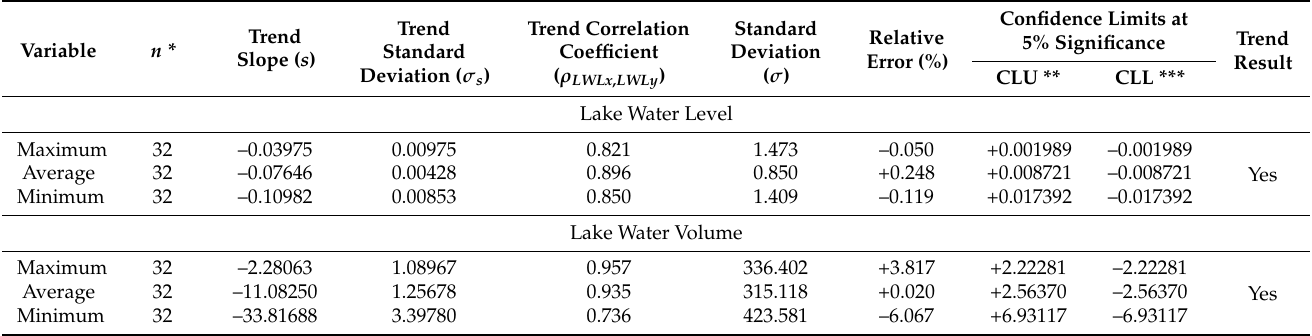
Table 8. ¸Sen innovation trend test results for the LWL and LWV